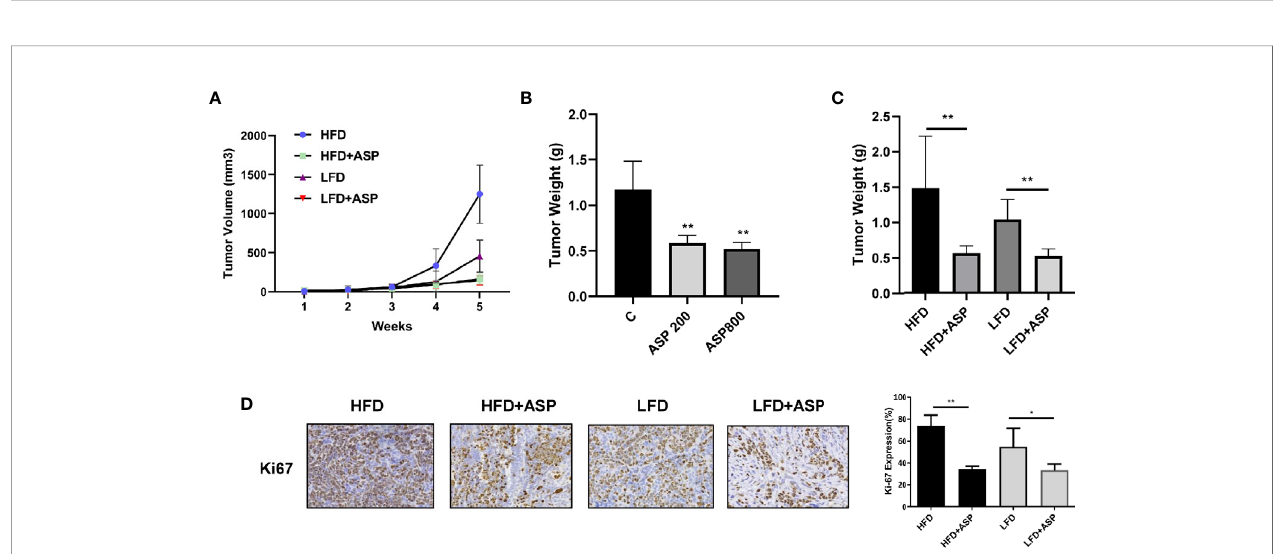
FIGURE 5 | ASP inhibited tumor growth in a transgenic mouse model of OC (KpB). The KpB mice were treated with 200mg/kg or 800mg/kg ASP daily for 4 weeks after ovarian tumors reached 0.1 cm in diameter. Treatment with 200 mg/kg ASP inhibited tumor growth in KpB mice (A) . There was no signi fi cant difference in tumor weights after treatment with 200mg/kg versus 800mg/kg ASP (B) . The KpB mice were then fed either a HFD (obese) or LFD (lean) at 3 weeks age of birth. The HFD and LFD mice were treated with 200 mg/kg ASP daily for 4 weeks when their ovarian tumors reached 0.1 cm in diameter. ASP signi fi cantly reduced tumor weights in both the HFD and LFD groups as compared to the vehicle treated controls (C) . IHC results showed that ASP decreased Ki-67 expression in the ovarian tumor tissues in the obese and lean mice (D) . *p < 0.05; **p <